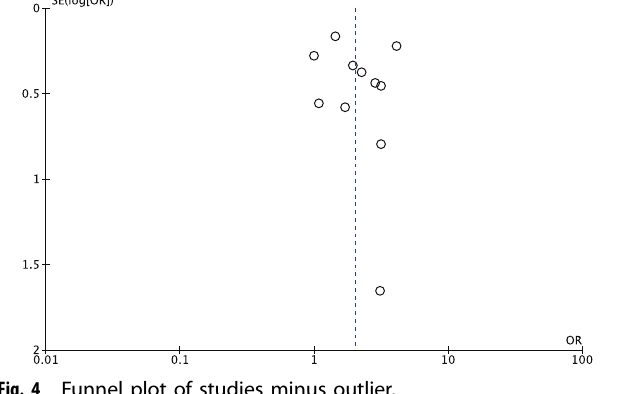
(Fig. 13). For all crossover studies (OR: 2.45, 95% CI: 1.35, 4.47, I 2 = 80%), articaine had 2.45 times likelihood of anaesthetic success of lidocaine. The results were signi fi cant ( P = 0.003) (Fig. 14). Publication bias funnel plot A funnel plot was used to assess publication bias. Most studies fell within the funnel with one outlier, but the sensitivity effect was insigni fi cant for omission any of the studies (Figs. 3 and 4). Adverse effects Of the 12 included studies in this meta-analysis, four did not include data on LA-related adverse effects, the remaining nine stated that there were only minor temporary side-effects with no reported incidence of paraesthesia.